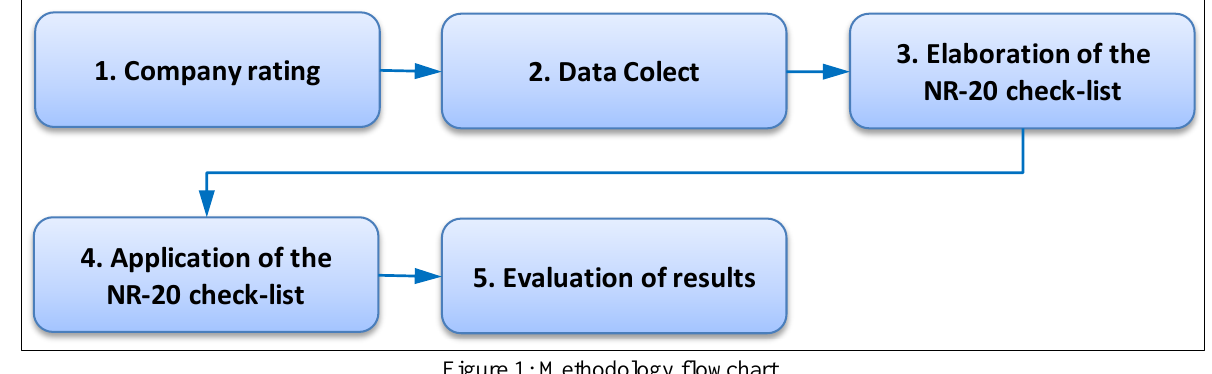
Figure 1: Methodology